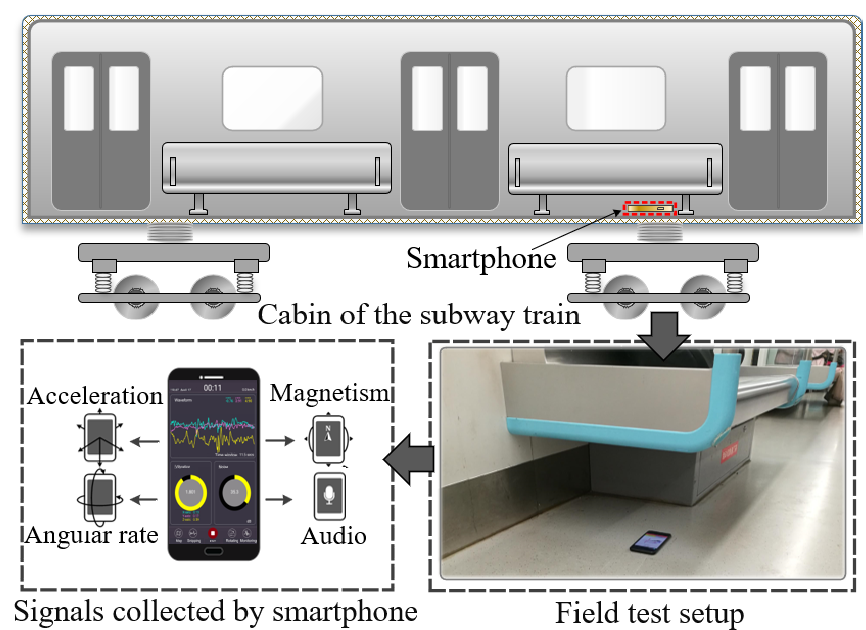
Figure 2. Data collection with the smartphone.